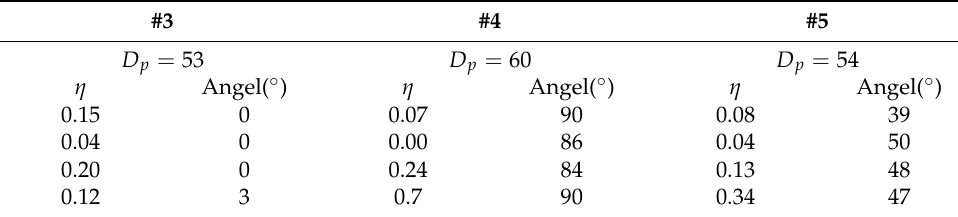
Table 4. Crack defect location detection accuracy and fracture